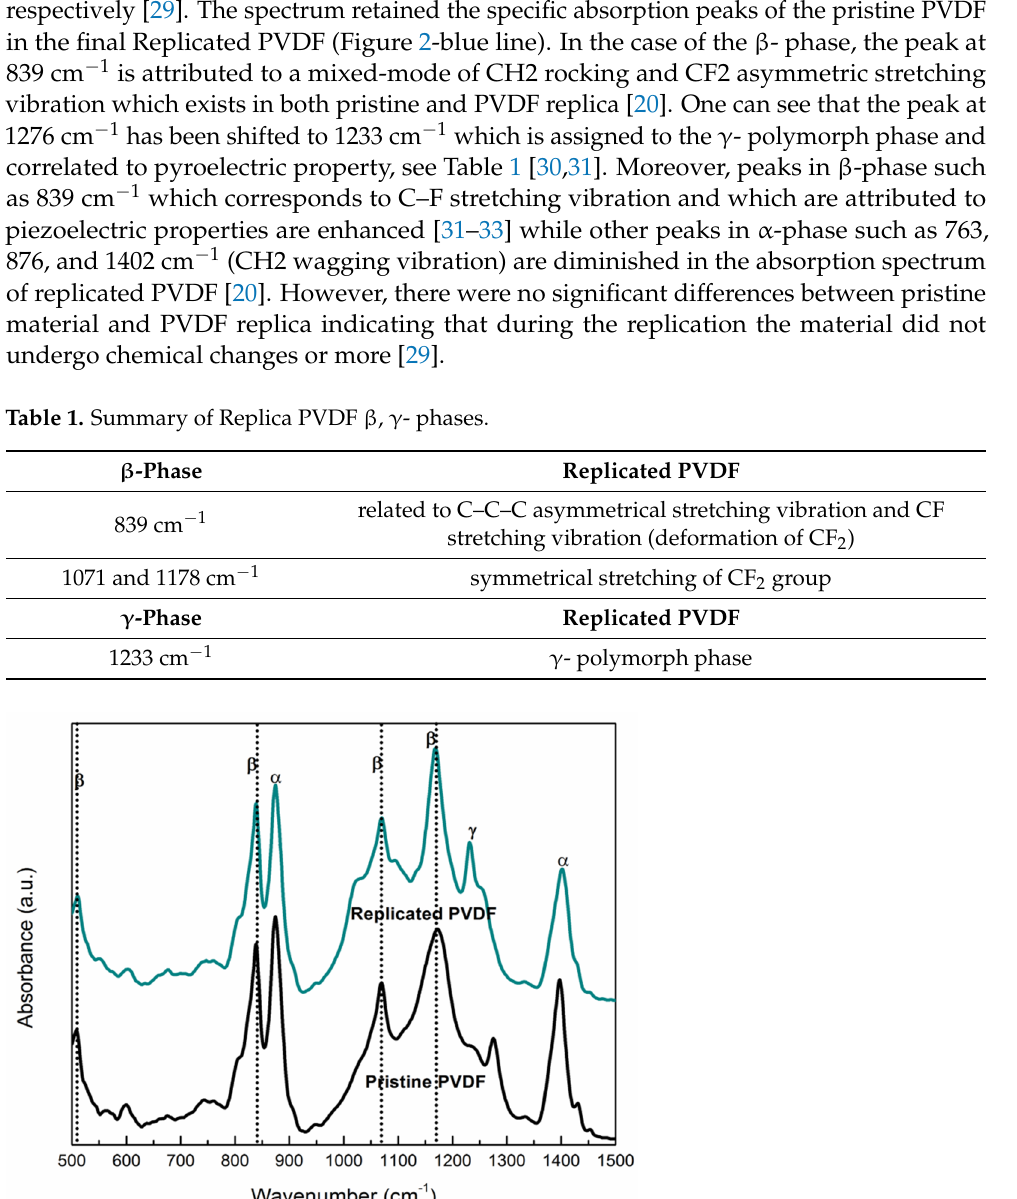
Figure 2. FT-IR spectra of Pristine PVDF (black line) and Replicated PVDF (colored line) .